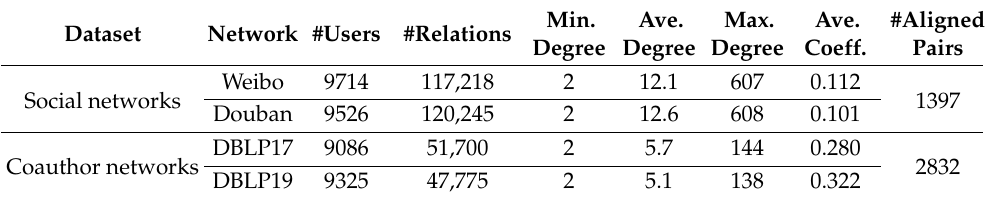
Table 2. The statistics of our data